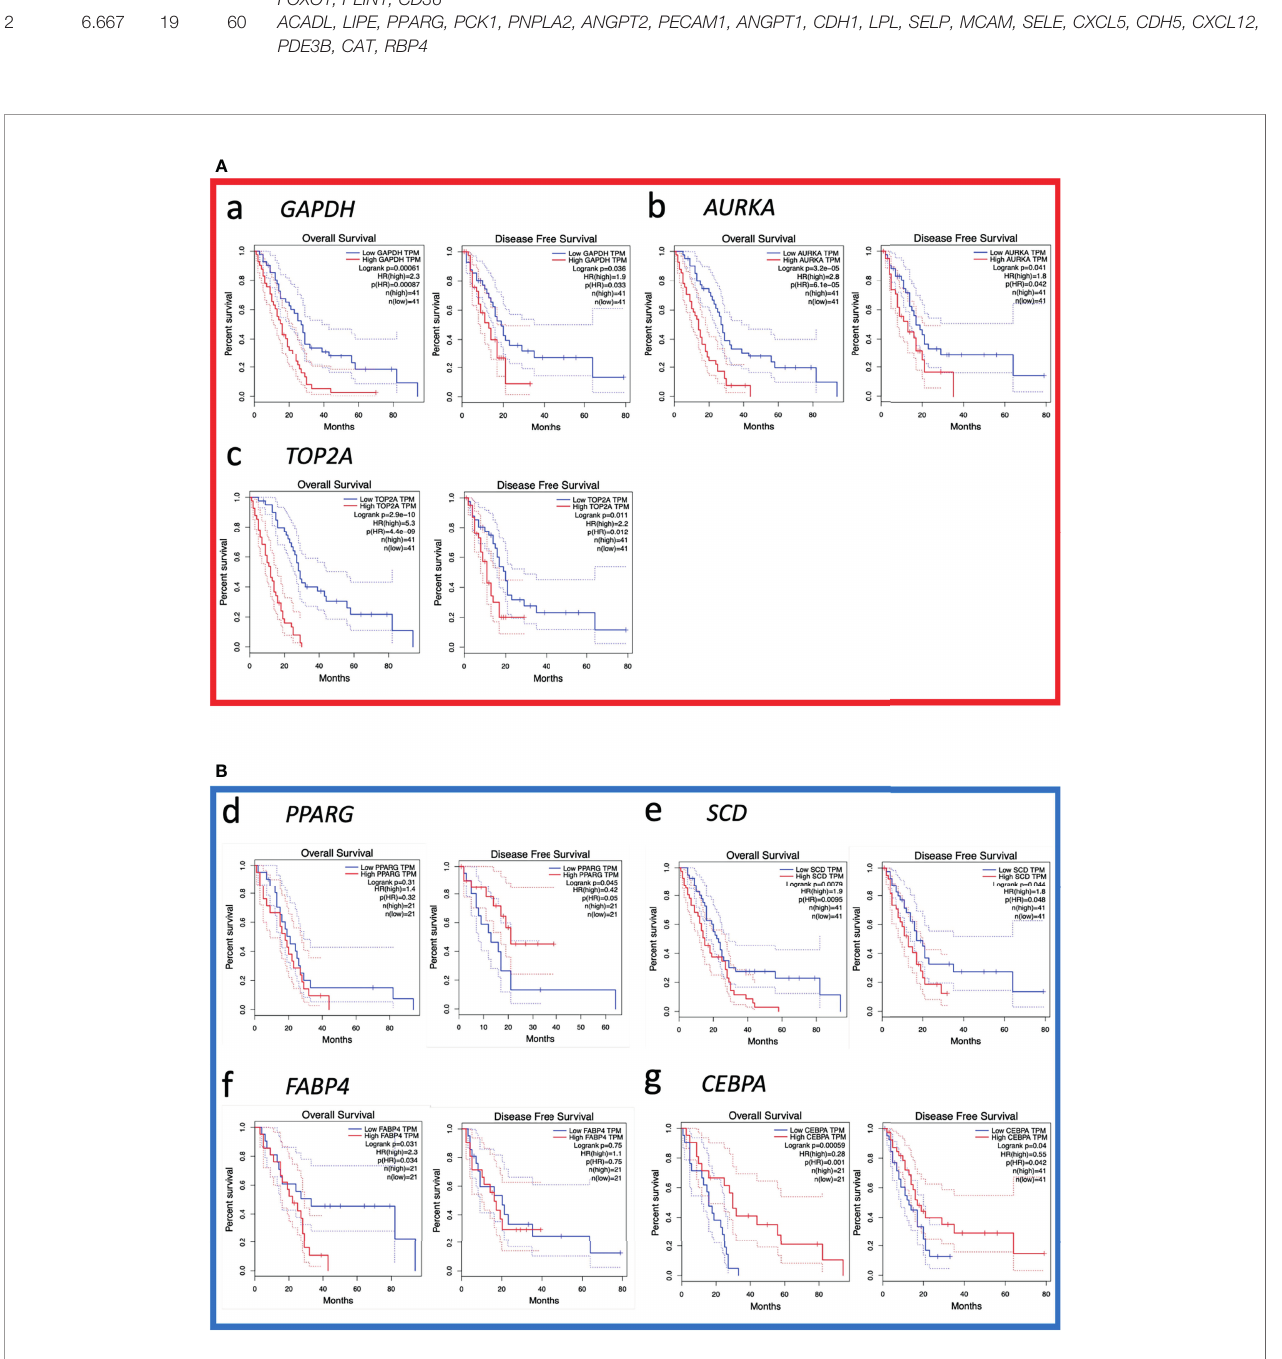
FIGURE 4 | Kaplan-Meier survival analyses for the top 20 hub genes expressed in malignant mesothelioma patients. (A) Upregulated genes are signi fi cantly associated with overall survival (OS) and/or disease-free survival (DFS; red square). (B) Downregulated genes are signi fi cantly associated with OS and/or DFS (blue square). The other 13 genes without signi fi cant associations with OS and DFS are shown in Supplemental Data